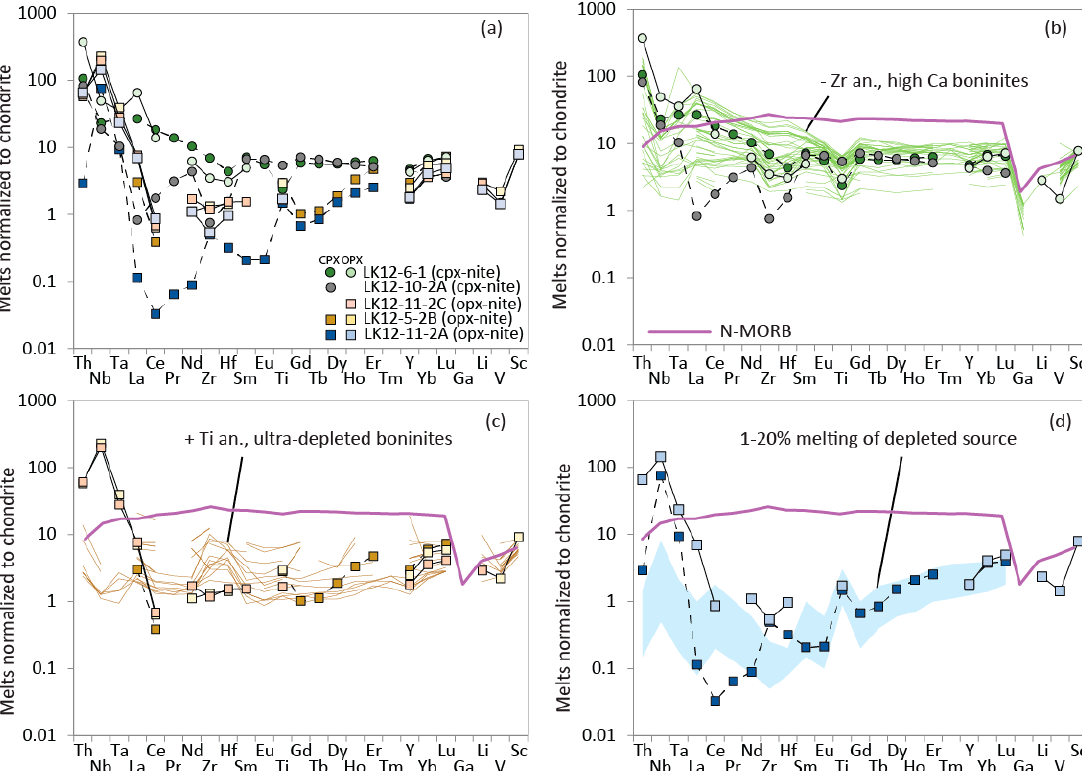
Figure 12. ( a ) Chondrite-normalized [42] trace element compositions of melts in equilibrium with clinopyroxenites and orthopyroxenites from the Josephine ophiolite compared with ( b ) worldwide EarthChem compilation of boninites that display a negative Zr anomaly and CaO / Al 2 O 3 > 0.75. Erupted Josephine boninites [34] are included in the compilation. ( c ) Worldwide EarthChem compilation of ultra-depleted boninites that display a slight positive Ti anomaly, and ( d ) 1–20% melting of a depleted peridotite source [59]. The boninite data was compiled from the EarthChem repository (http: // www.earthchem.org / ) and filtered to retain true boninite compositions (SiO 2 > 52%, MgO > 8%, and TiO 2 < 0.5%; [77]). Average N-MORB is also plotted for reference